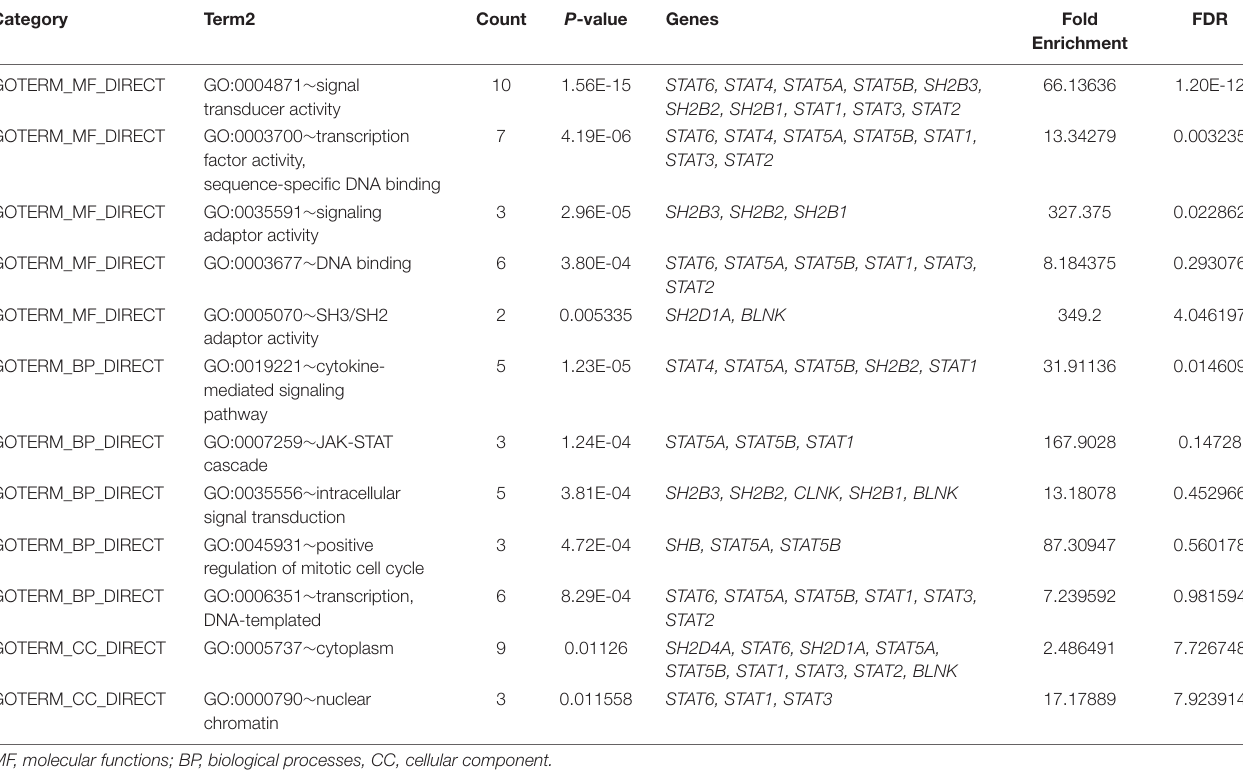
TABLE 4 | Gene ontology terms enrichment (including TOP 5 MF, TOP 5 BP and TOP 2 CC). Category